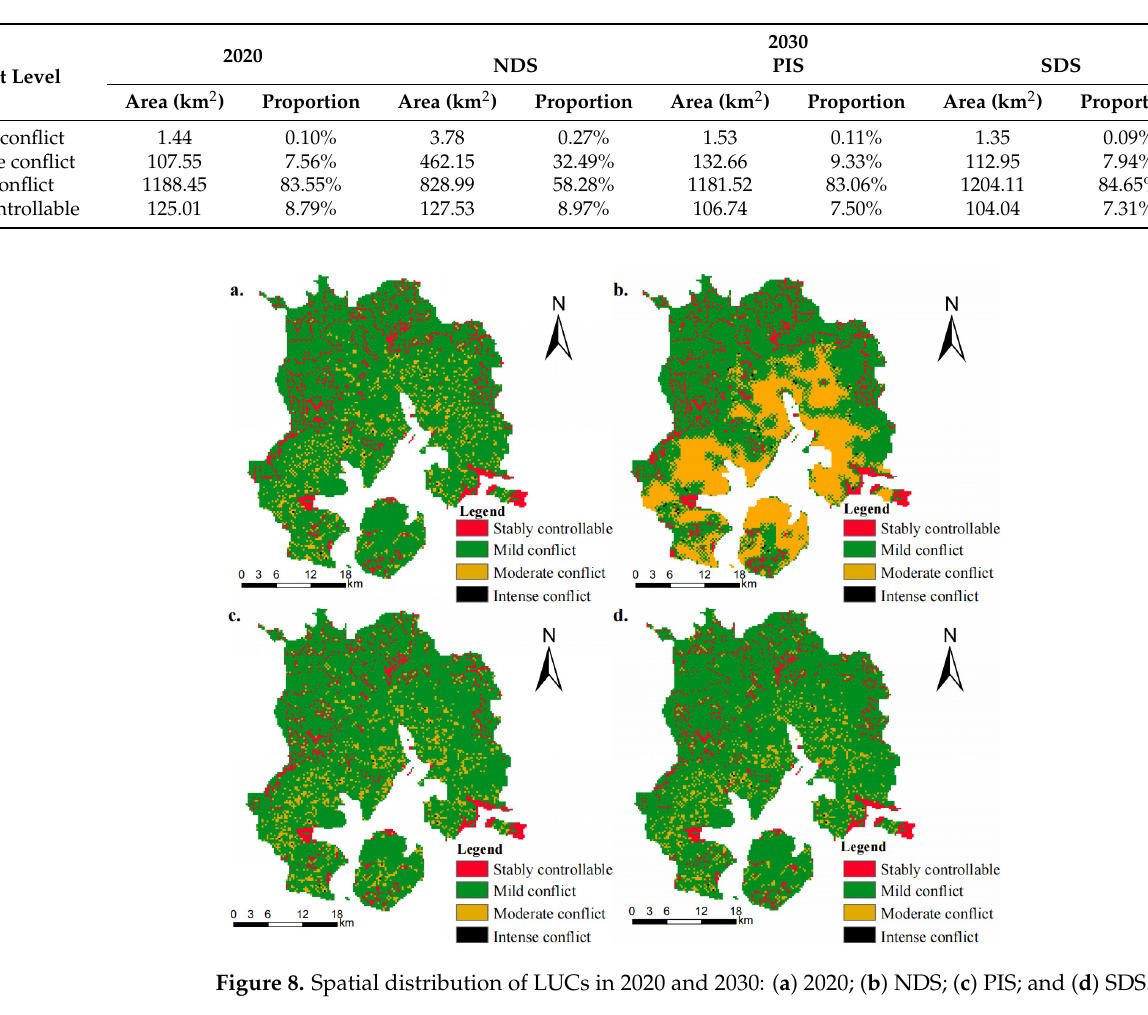
Table 6. The calculated result of LUCs indexes in Xiamen in 2020 and 2030.